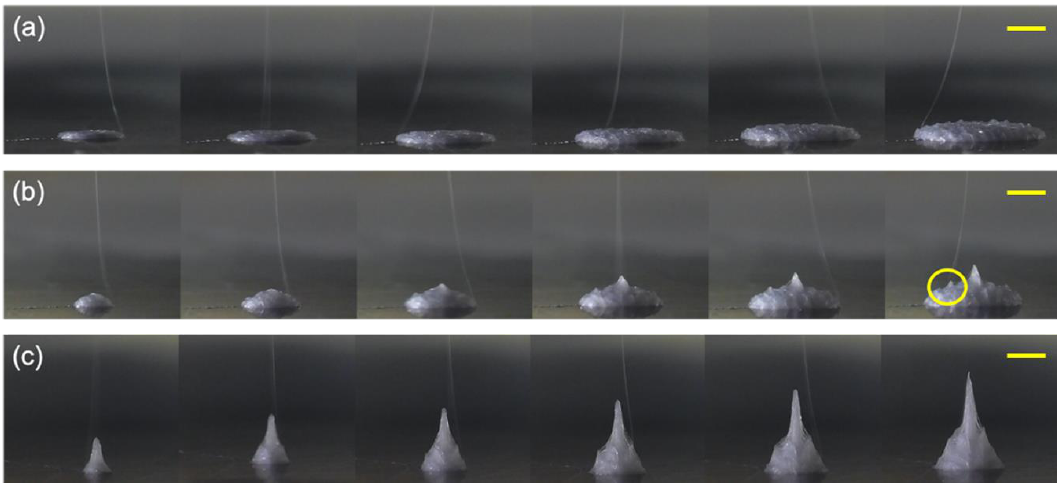
Figure 2. Evolution of the fiber deposit with deposition time. ( a – c ) printed at 16, 23.5, 30 °C, respectively. Left to right: 1, 2, 3, 4, 5, 6 min. The yellow circle indicates the existence of lower cones around the central cone. The scale bars denote 2 mm.